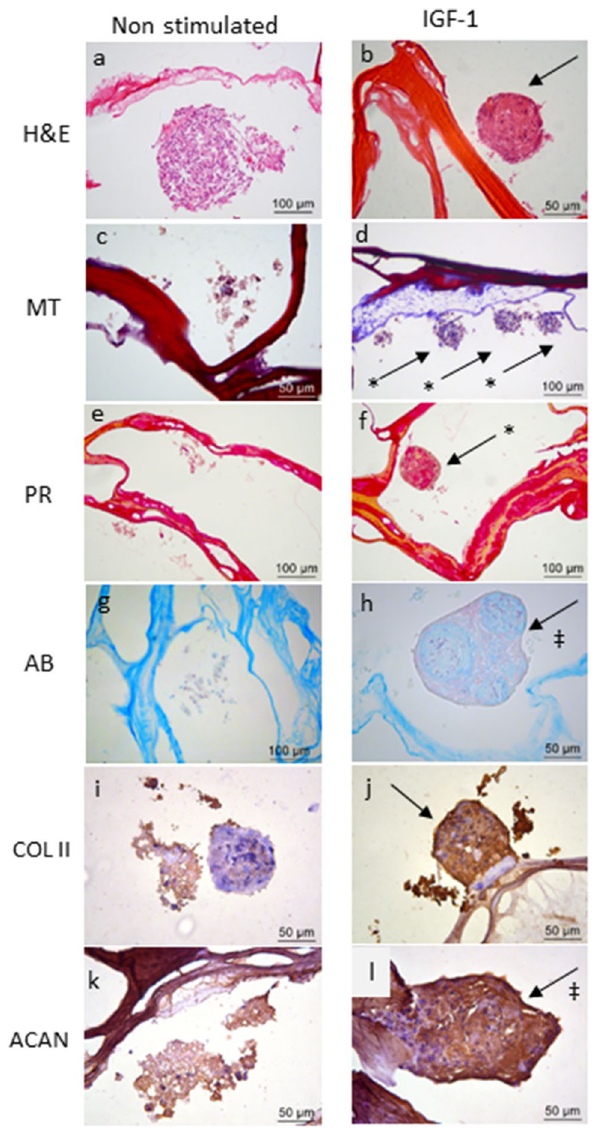
Figure 4. Chondrogenic differentiation of CD117 + AFSCs seeded into CX scaffold for 21 days with and without IGF-1 stimulation. In the group stimulated by IGF-1 ( b , d , f , h , j , l ) more compact agglomeration of the cells is observed,with a higher amount of extracellular material compared to that noticed in the non-stimulated control group ( a , c , e , g , i , k ). H&E staining ( a , b ); collagen (indicated with *) stained in blue by Masson´s trichrome (MT) ( c , d ); collagen fibers shown in red by Picrosirius red (PR) ( e , f ); glycosaminoglycans (‡) stained light blue using Alcian blue (AB) ( g , h ). Labeling with anti-collagen type II antibody (COL II) ( i , j ) and anti-aggrecan antibody (ACAN) ( k , l ) in the stimulated group compared to the control